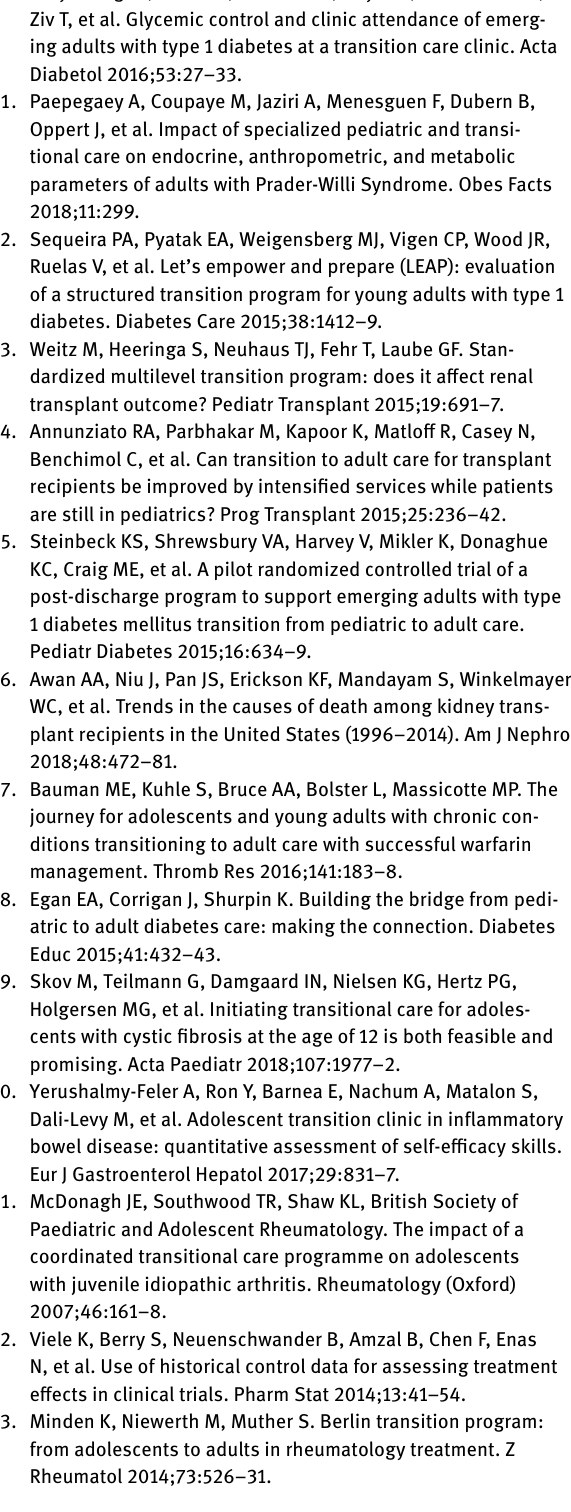
Supplementary material: The online version of this article